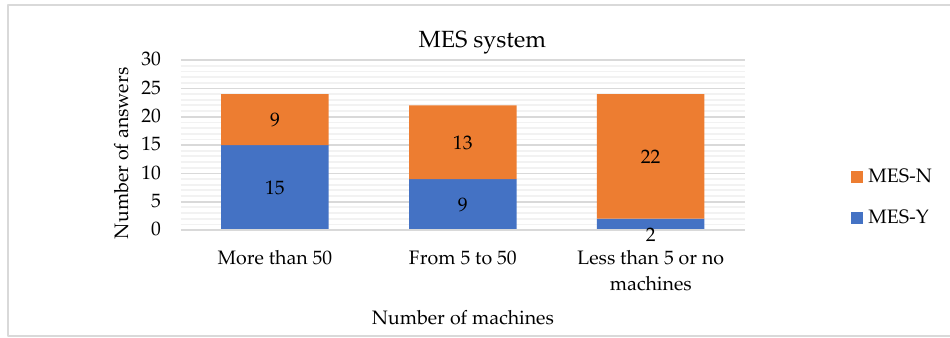
Figure 27. Number of companies having MES system implemented (MES-Y) or not (MES-N) by number of machines.